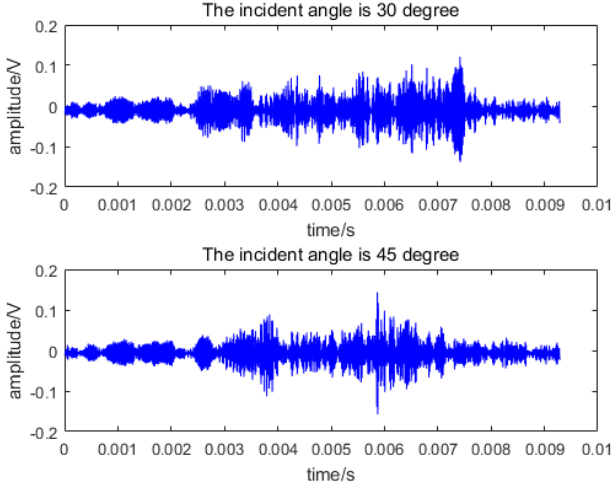
Figure 8. Original echo signal.